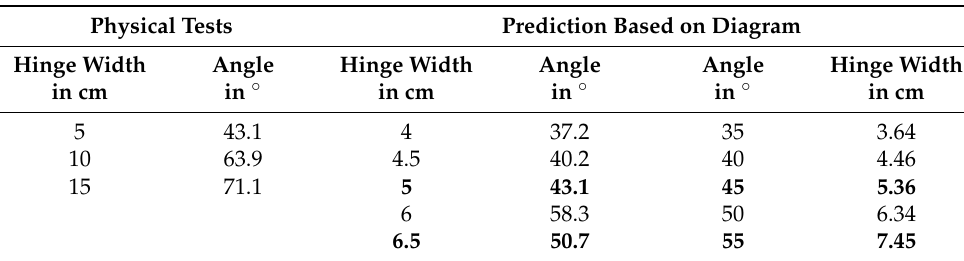
Table 4. Bending angle dependent of hinge widths (physical tests) and prediction of bending angle/hinge width (regression formula from Figure 13 used).